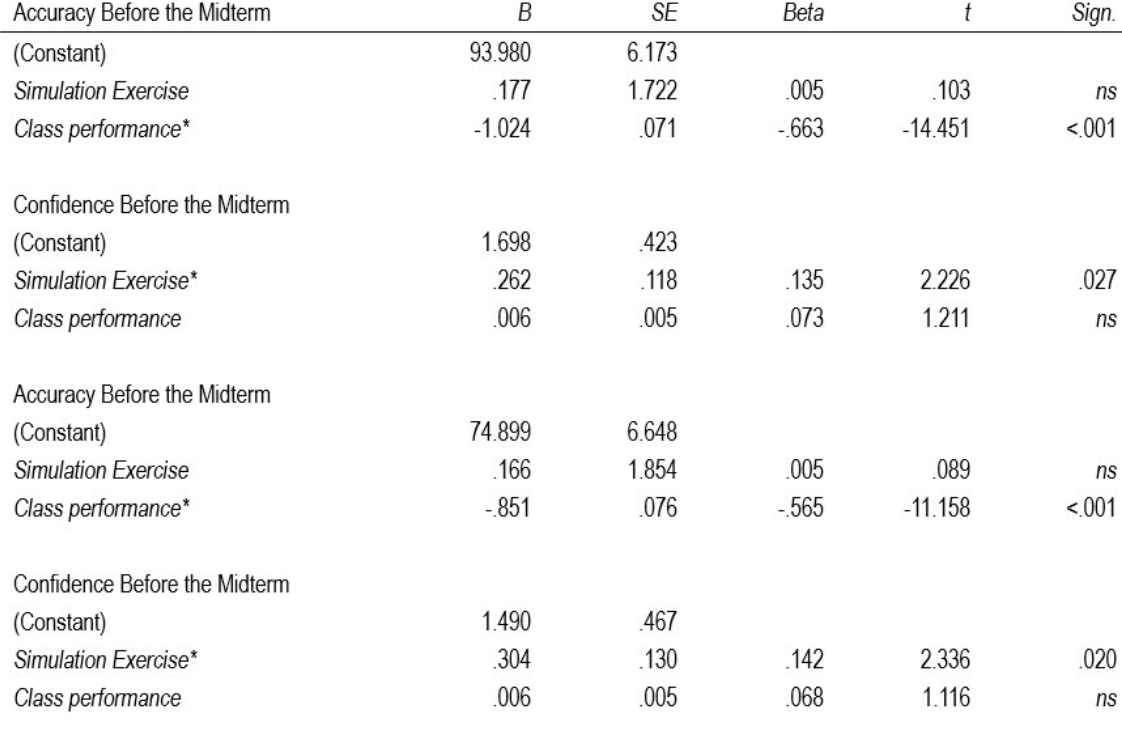
Regression Analysis with Estimates or Subjective Confidence as the Outcome Variable and Simulation Exercise (Outcome Versus Process) and Class Performance as the Predictors